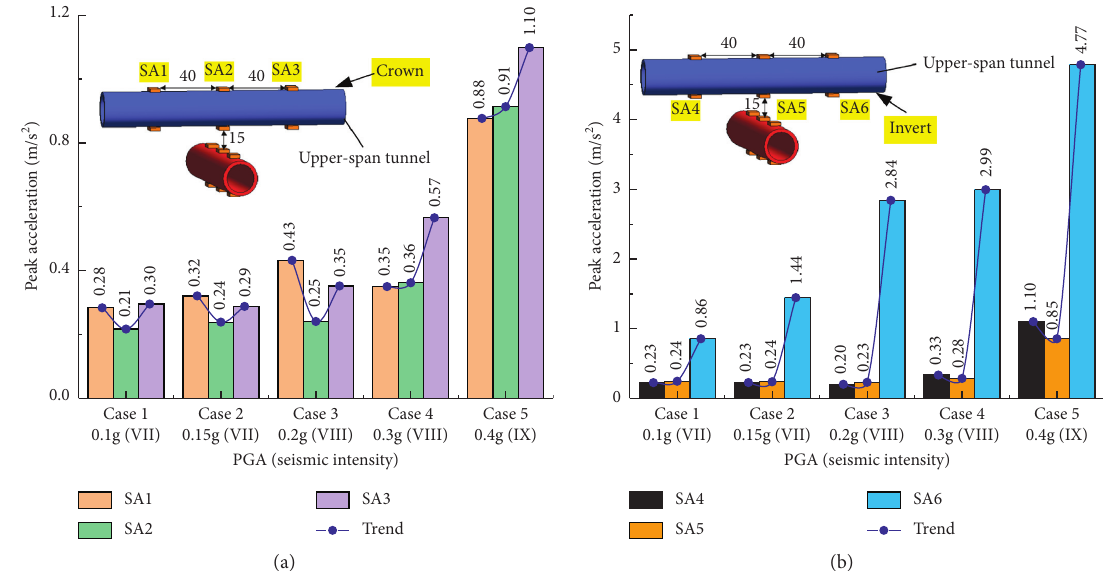
Figure 8: Peak acceleration of the upper-span tunnel: (a) crown; (b)